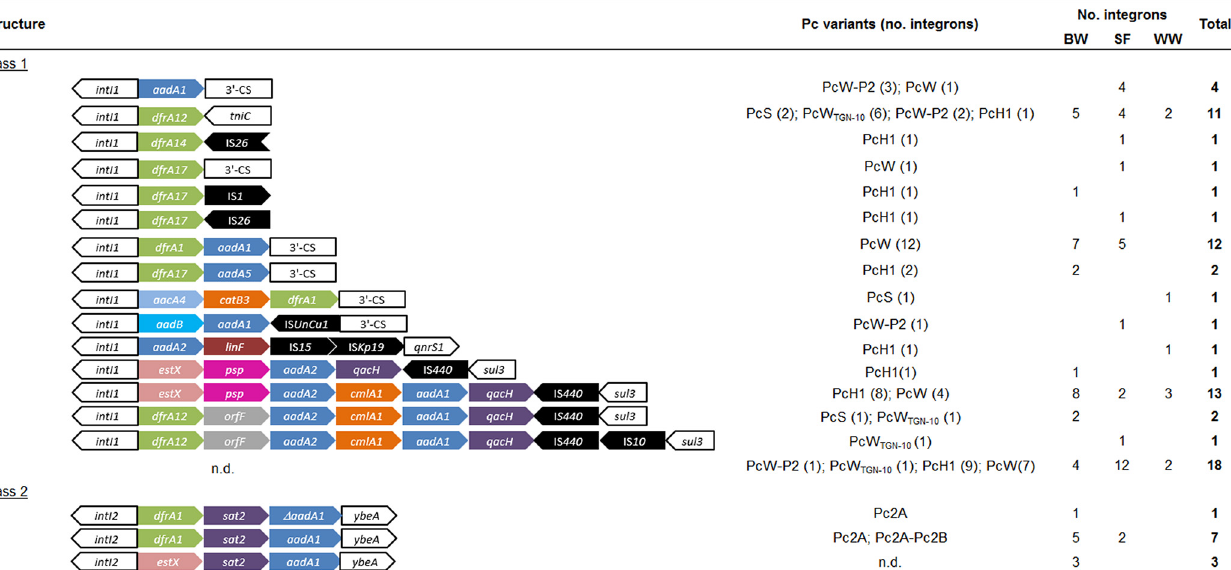
Table 3 | Overview of the gene cassette arrays and Pc promoter variants present in the 82 integron structures detected in this study